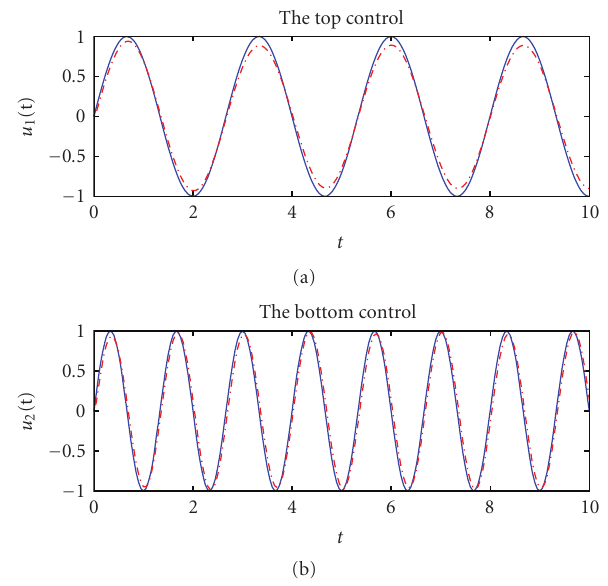
Figure 4: Boundary control